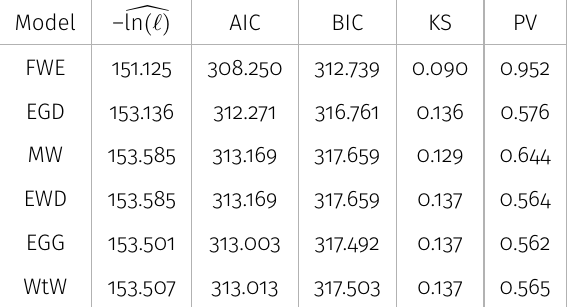
Table VI. The log-likelihood, AIC, BIC, KS and p-values for the fitted distributions for survival times data.